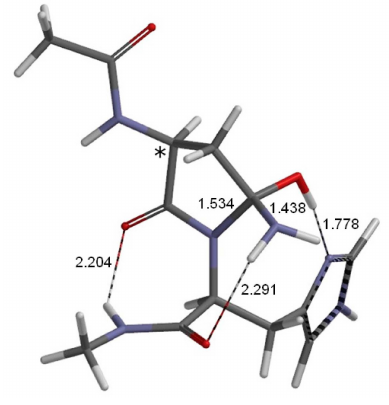
Figure 5. The optimized geometry of INT1, the intermediate directly connected to TS1 ( ϕ N = ´ 169 ˝ , ˝ , χ ˝ , ϕ ˝ , ψ ˝ , χ ˝ ). Relevant bond distances are shown in Å. ψ N = ´ 150 1N = 155 H = ´ 85 H = 85 1H = ´ 65 The asterisked carbon corresponds to the Asn α carbon in the reactant